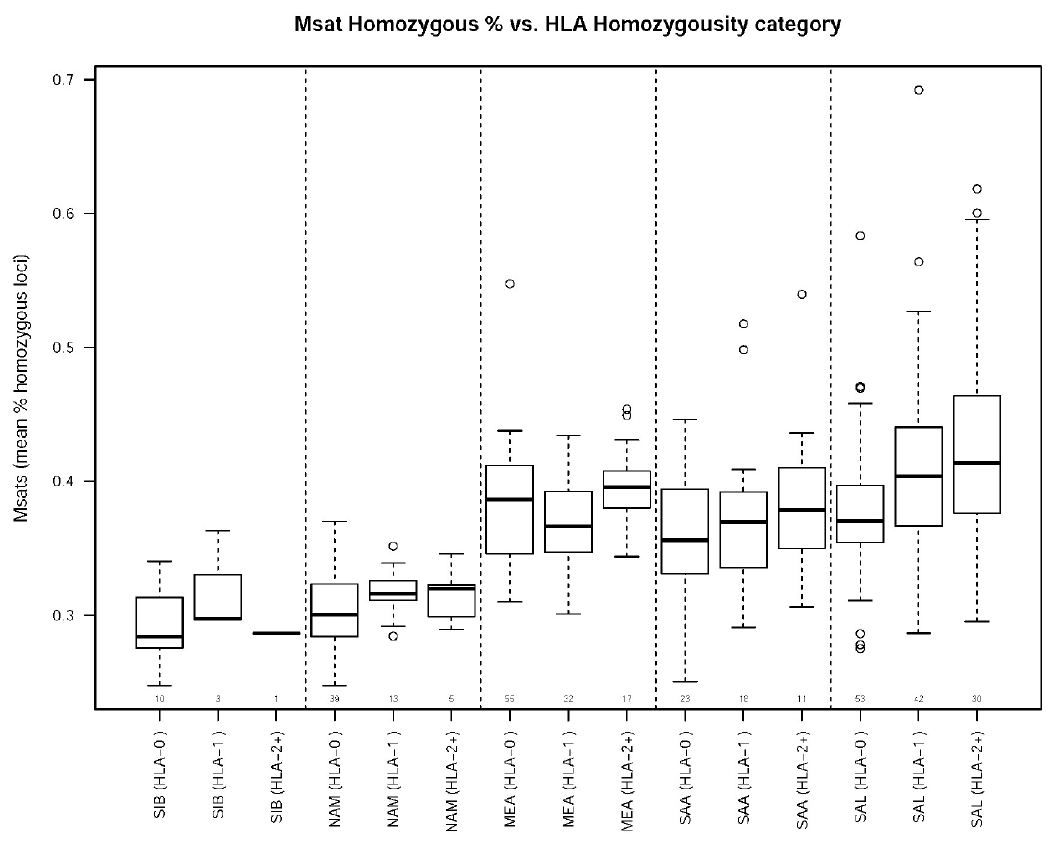
Fig 5. Relationship between zygosity at HLA loci and the average proportion of microsatellite loci for which individuals are homozygous. The proportion of microsatellite loci that are homozygous in each individual is summarized over individuals from each geographic region, separately for individuals with zero, one, or at least two homozygous HLA loci. The number of individuals in the geographic region contributing to each boxplot is shown on the horizontal axis.